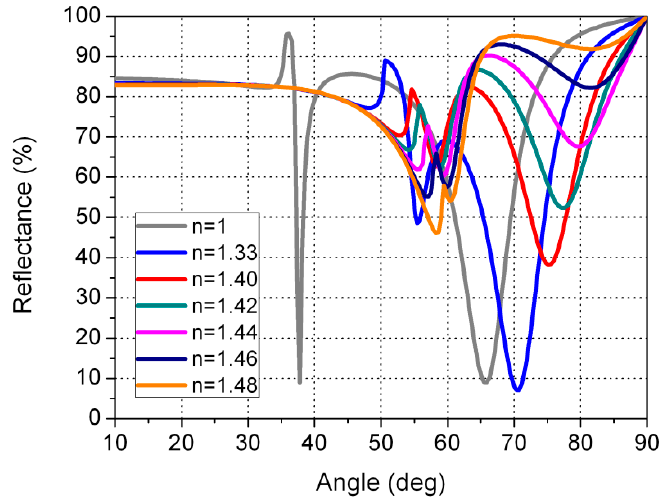
Figure 5. Reflectance curves as a function of the angle of incidence of the light in the prism. These represent the curves when the sensor is in contact with air (cid:4666)(cid:1866) = 1(cid:4667) , water (cid:4666)(cid:1866) = 1.33(cid:4667) , and gasoline or diesel fuel (cid:4666)(cid:1866) = 1.40 − 1.48(cid:4667) . The thickness of the gold layer is 48 nm, and the thickness of dielectric layer of the MgF 2 is 190 nm.